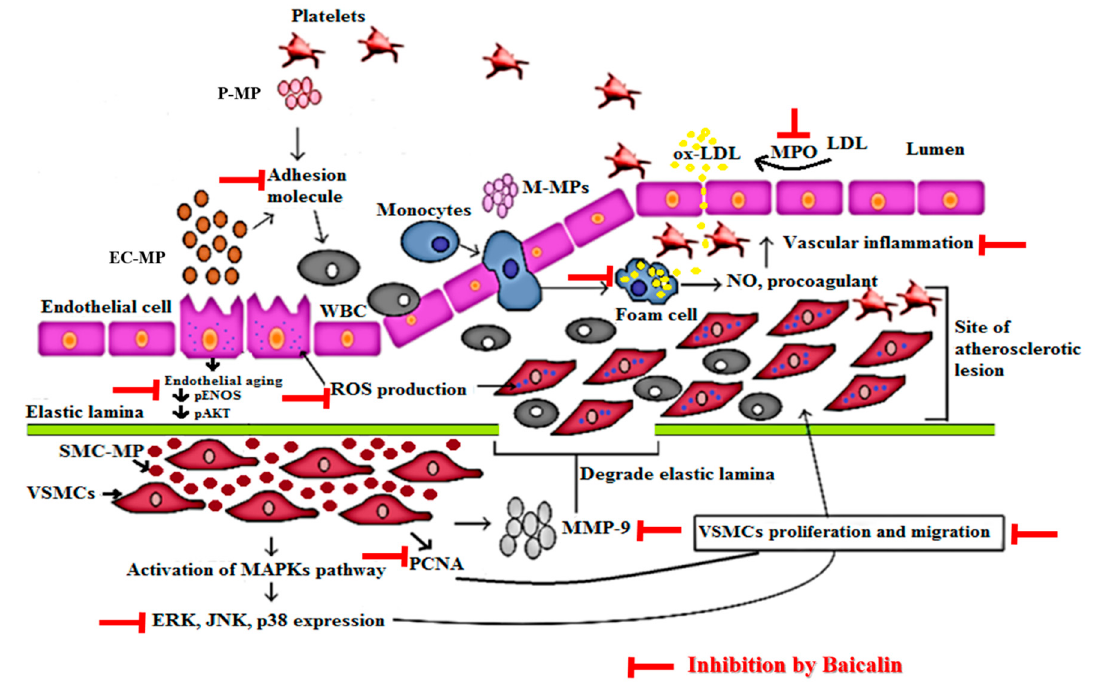
Figure 9. Mechanism of vascular inflammation mediated by microparticles and target of baicalin. Endothelial cell (EC), vascular smooth muscle cell (VSMC), and macrophage cell activation in response to various stimuli such as ROS, LPS, tumor necrosis factor (TNF)- α , interleukin (IL) lead to the production of endothelial microparticle (EC-MP), smooth muscle cell-microparticles (VSMC-MP) and macrophage microparticles (MØ-MP) respectively. EC-MP increases the ROS production in EC, thereby reduce phosphorylated ENOS and Akt expression followed by a decrease in nitric oxide (NO) production (a potent vasorelaxant). VSMC-MP stimulates VSMC to express matrix metalloproteinase-9 (MMP-9), leading to the degradation of the elastic lamina barrier and ease VSMC migration to the site of the atherosclerotic lesion. Furthermore, VSMC-MP also upregulates the mitogen-activated protein kinase pathway (MAPK) (ERK, JNK, P38) pathway and PCNA protein expression leading to proliferation and migration of VSMC to develop vascular inflammation. EC-MP and platelet microparticles (PMPs) possesses cell adhesion molecules that support the adhesion of various circulating cell the endothelial cell followed by altered intimal permeability and vascular lesion at a later stage. MØ-MP activated macrophage to uptake oxidized LDL and change in foam cell. This activated form of macrophage is responsible for the overexpression of nitric oxide (NO) and the procoagulant factor causing vascular inflammation. As a whole, all of this pathway leads to atherosclerosis. The target of baicalin to inhibit vascular inflammation is shown by the red line.